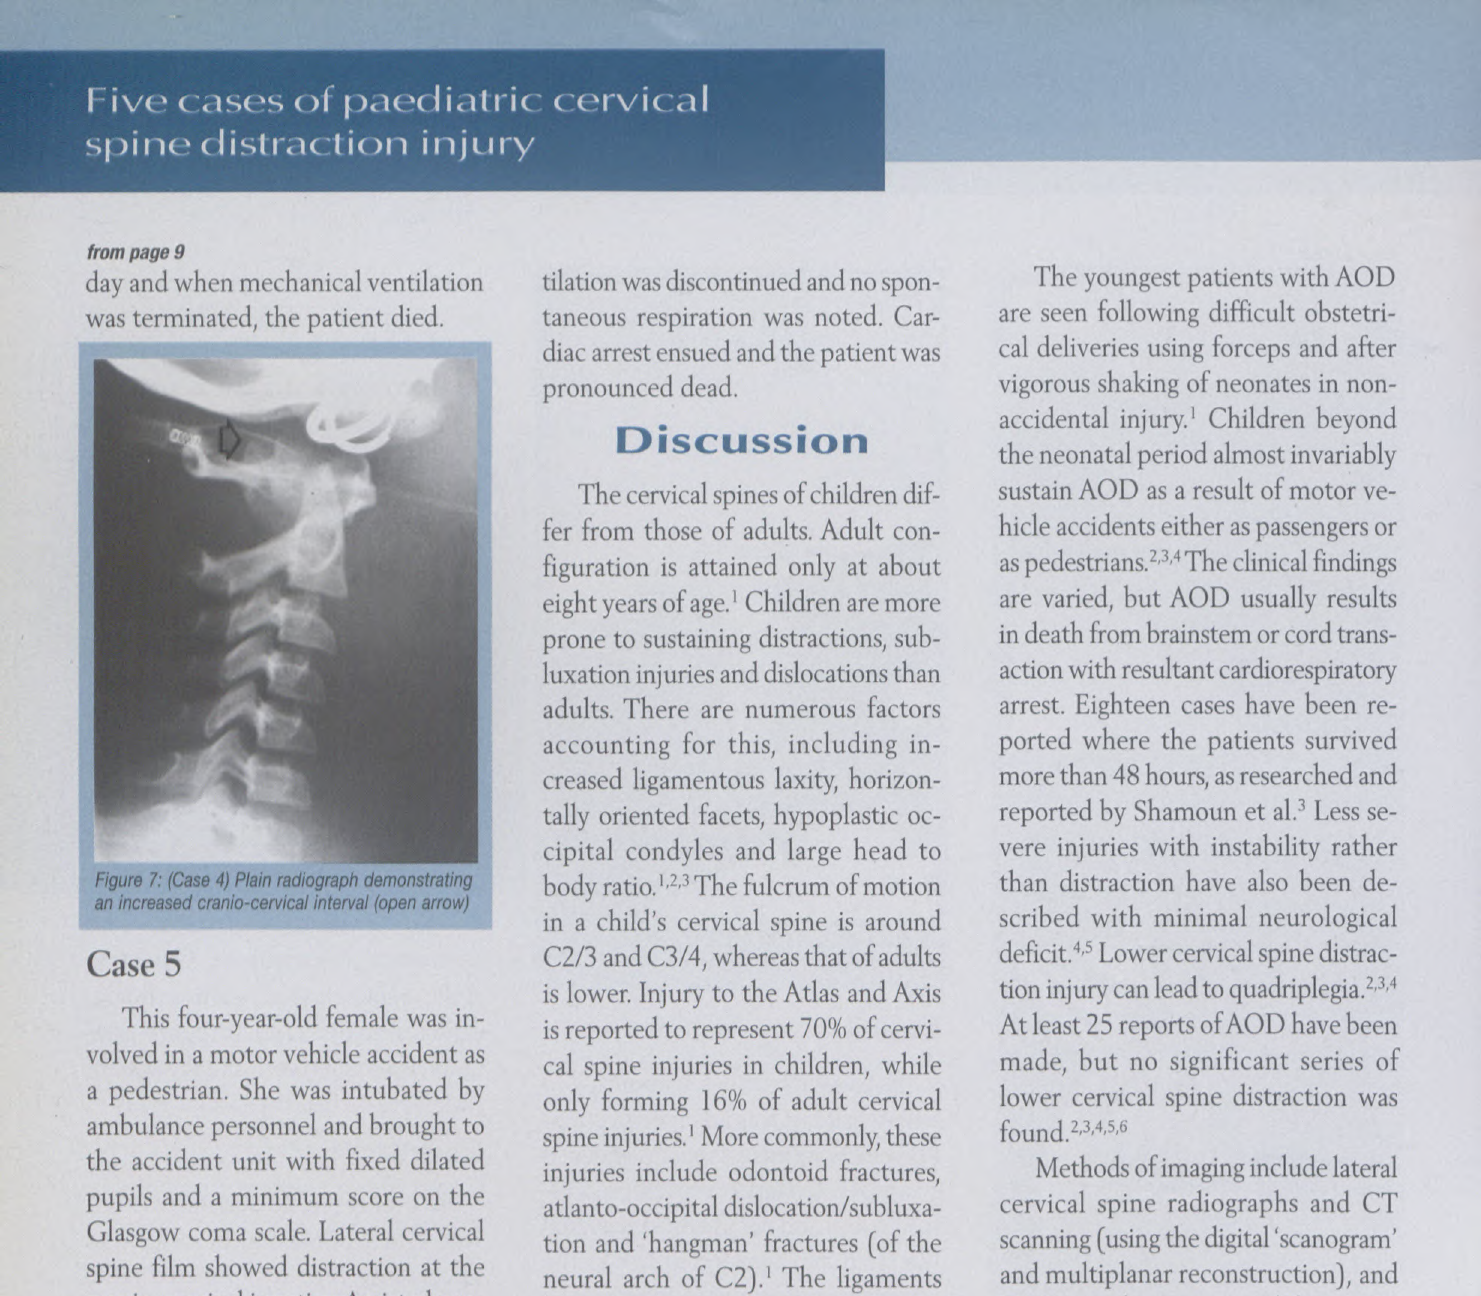
Figure 7: (Case 4) Plain radiograph demonstrating an increased cranio-cervical interval (open arrow)